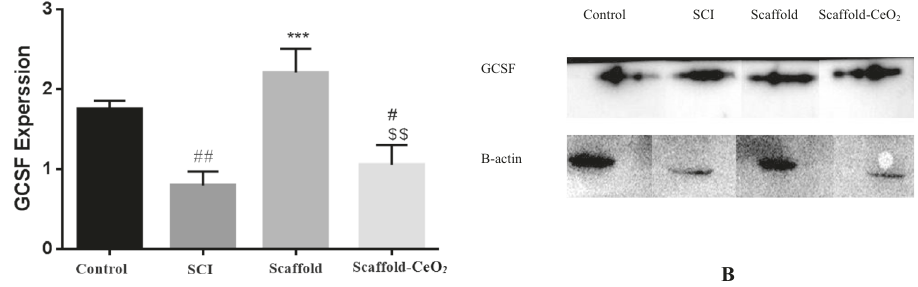
B Protein bands. Data is shown as mean ± SD, n = 3. ***, vs. SCI